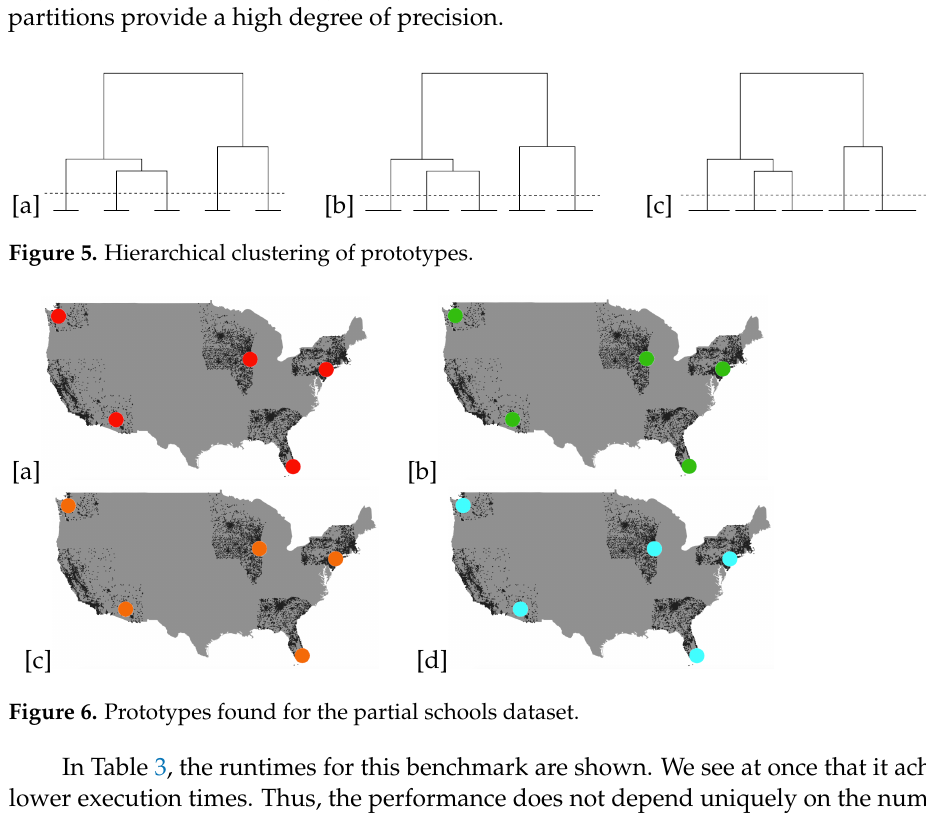
Figure 6. Prototypes found for the partial schools dataset.